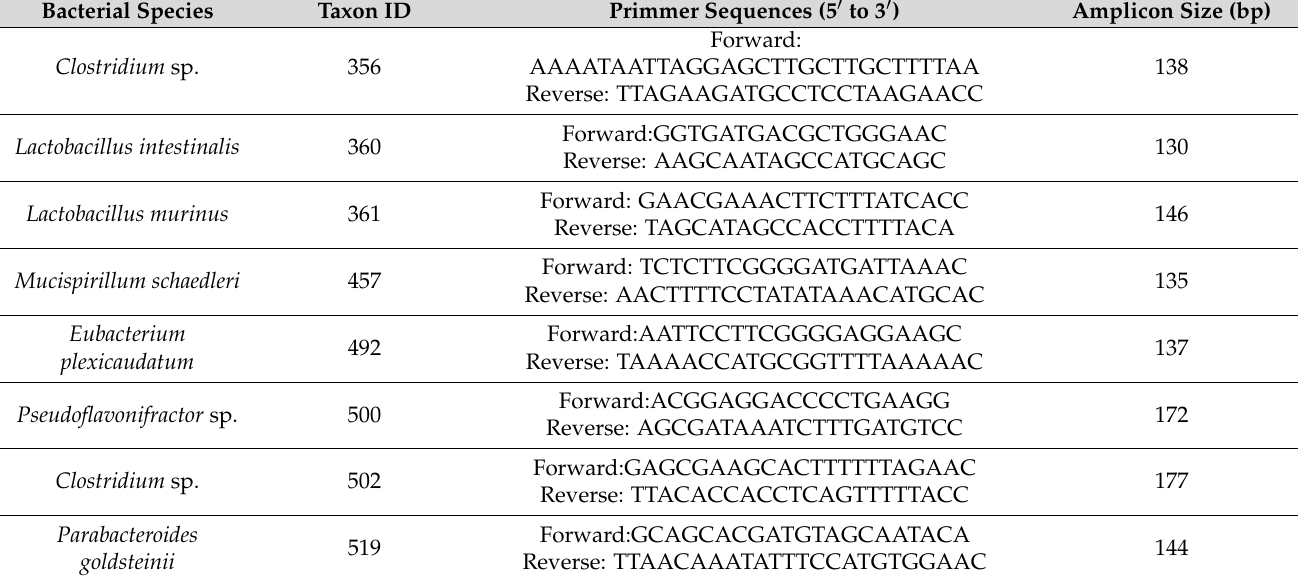
Table 1. Primers used for the detection of ASF species